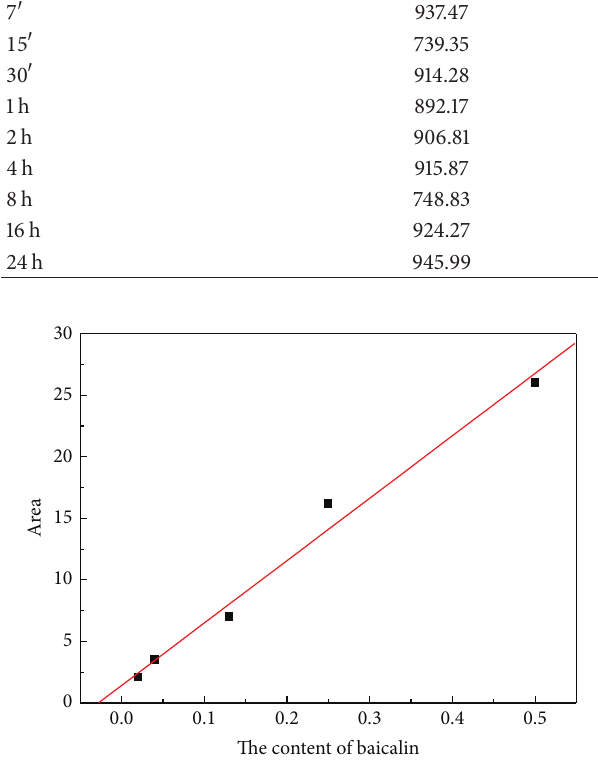
Figure 3: Baicalin standard curve.